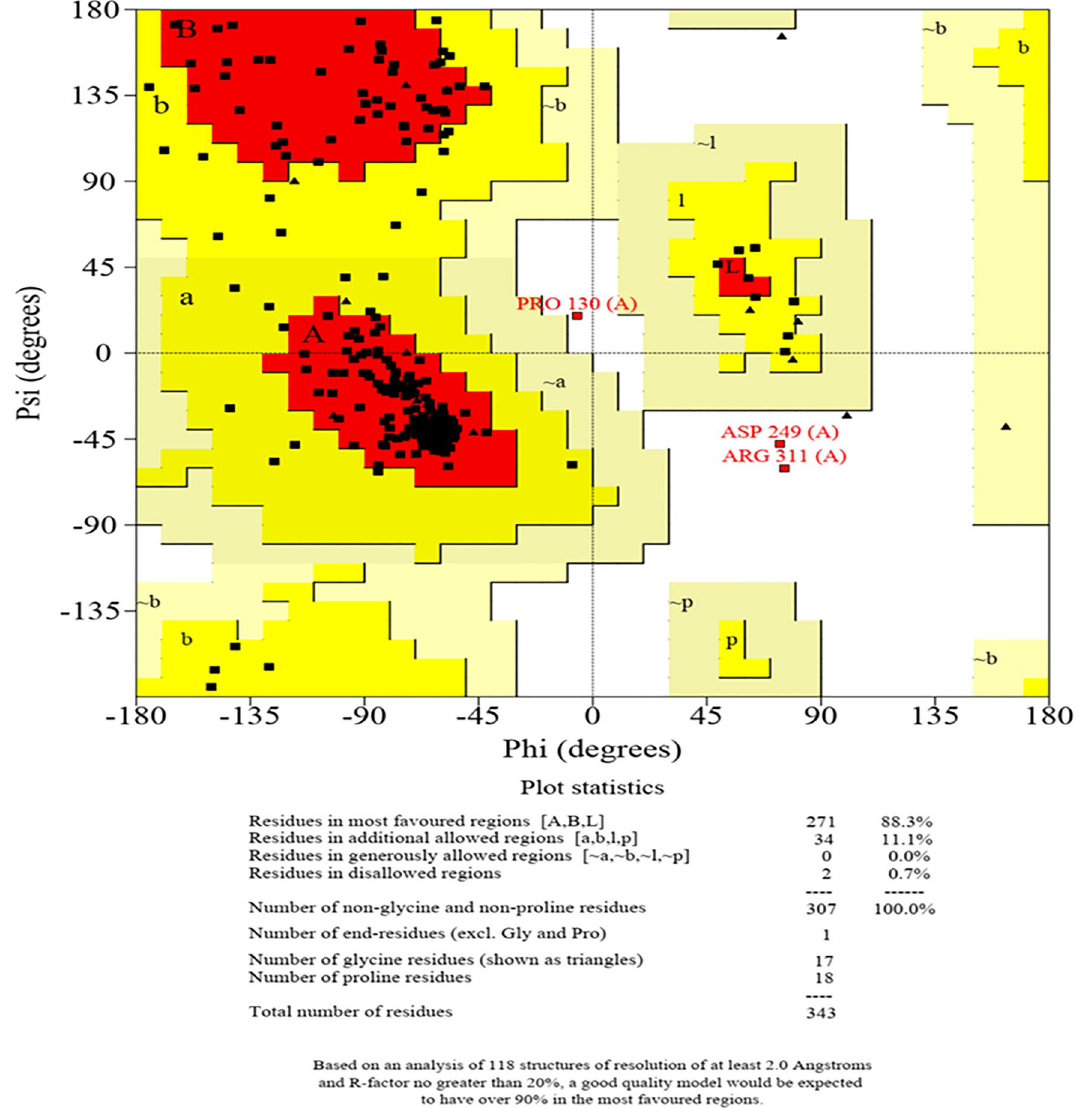
Figure 8. Ramachandran plot of the modeled PUB8 structure indicating two amino acids in the disallowed region as an indication of good quality